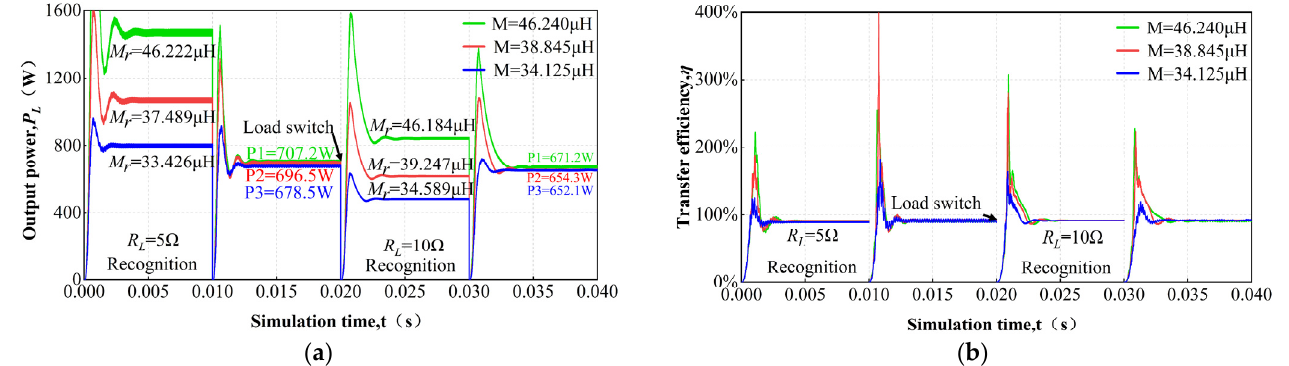
Figure 16. Variation in output power and efficiency when switching loads with different mutual inductance. ( a ) Output power; ( b ) Efficiency.